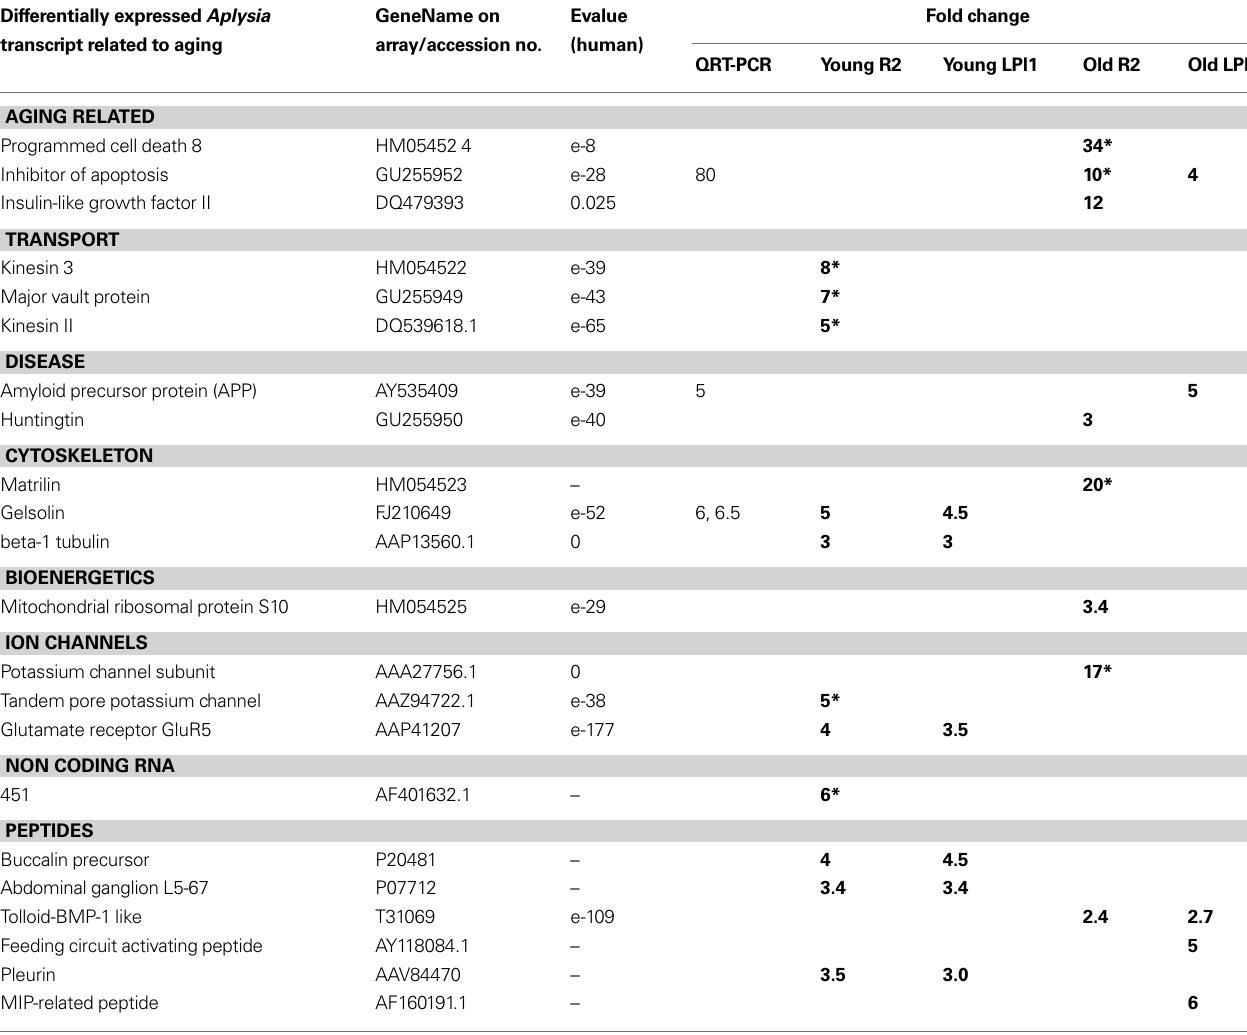
Table 2 | Age-related changes in expression of selected genes between two identifi ed cholinergic neurons: R2 and